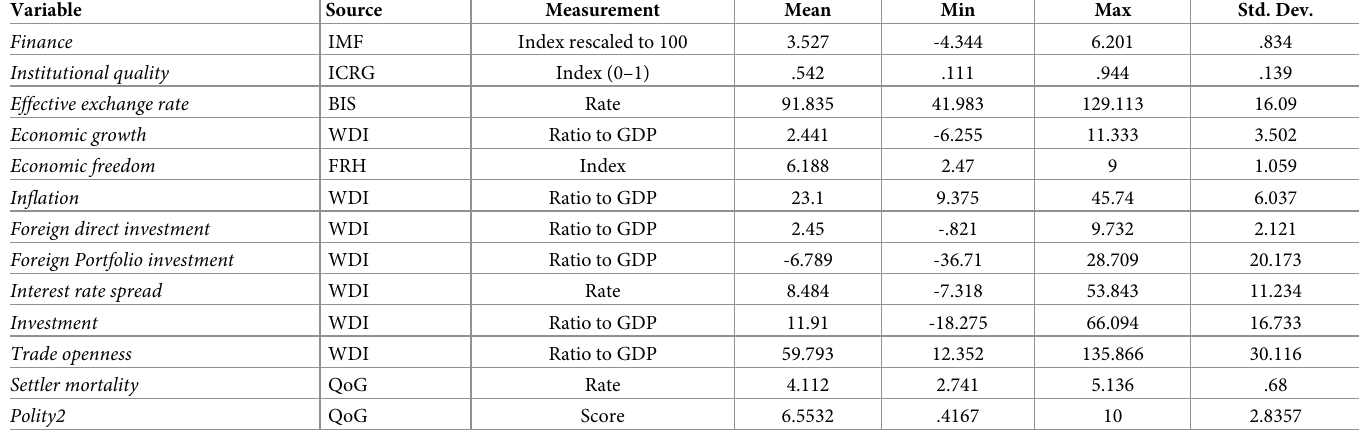
Table 1. Summary